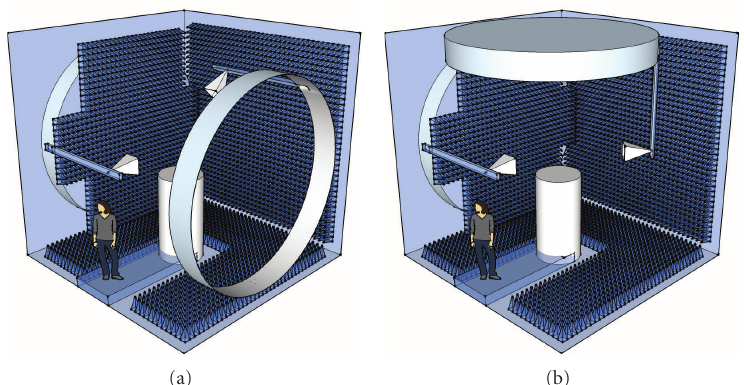
Figure 8: Examples for realization of 2-test-antenna setups in a distributed axis chamber.